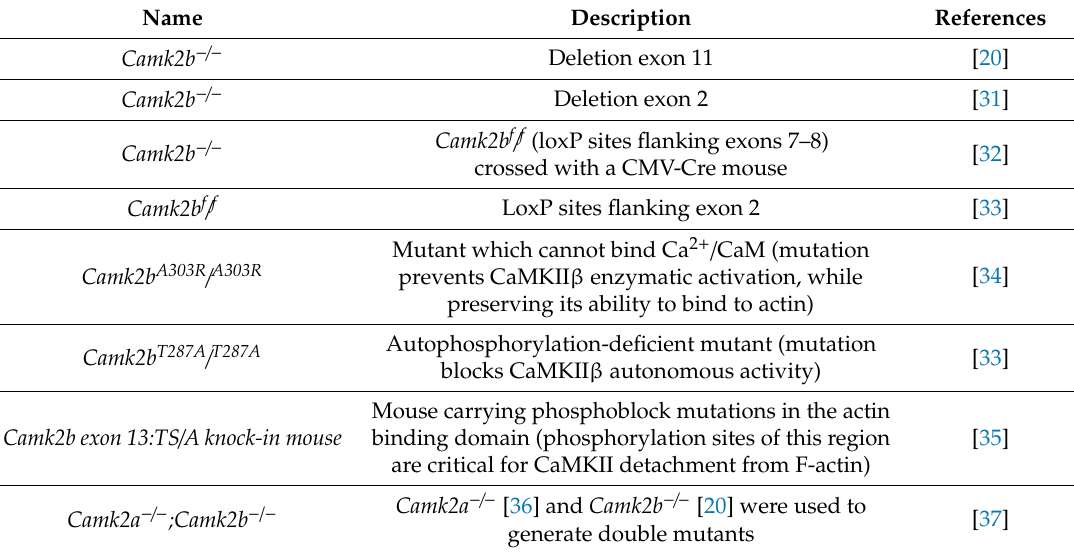
Table 3. Camk2b mutant